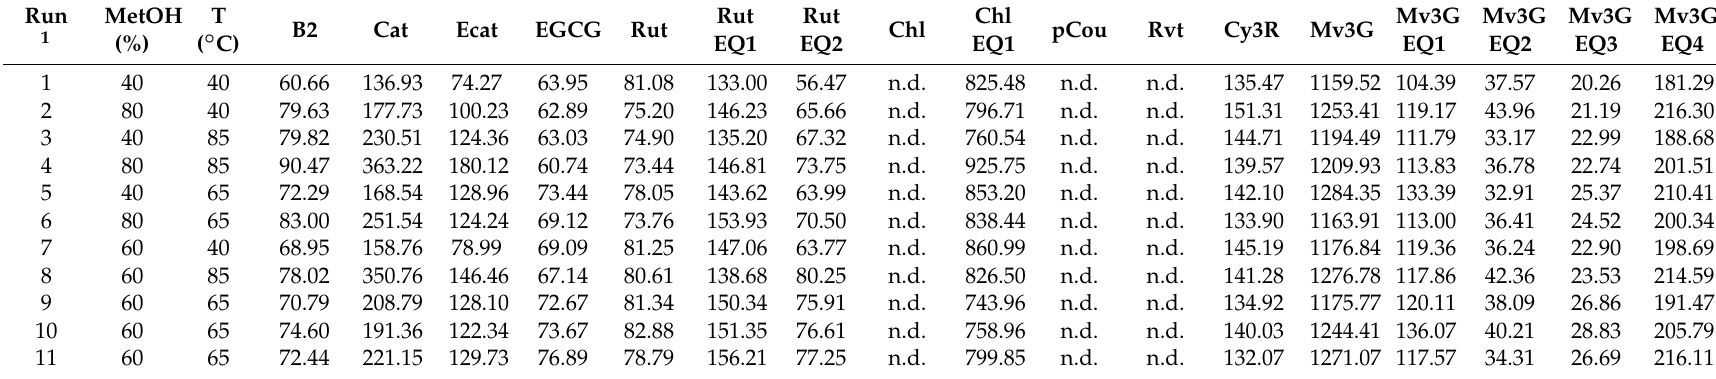
Table 1. Face-centered design setting of the independent variables and experimental results of flavanols, flavonols, hydroxycinnamic acids, stilbenes, and anthocyanins quantified by HPLC-DAD of organic whole red Grenache